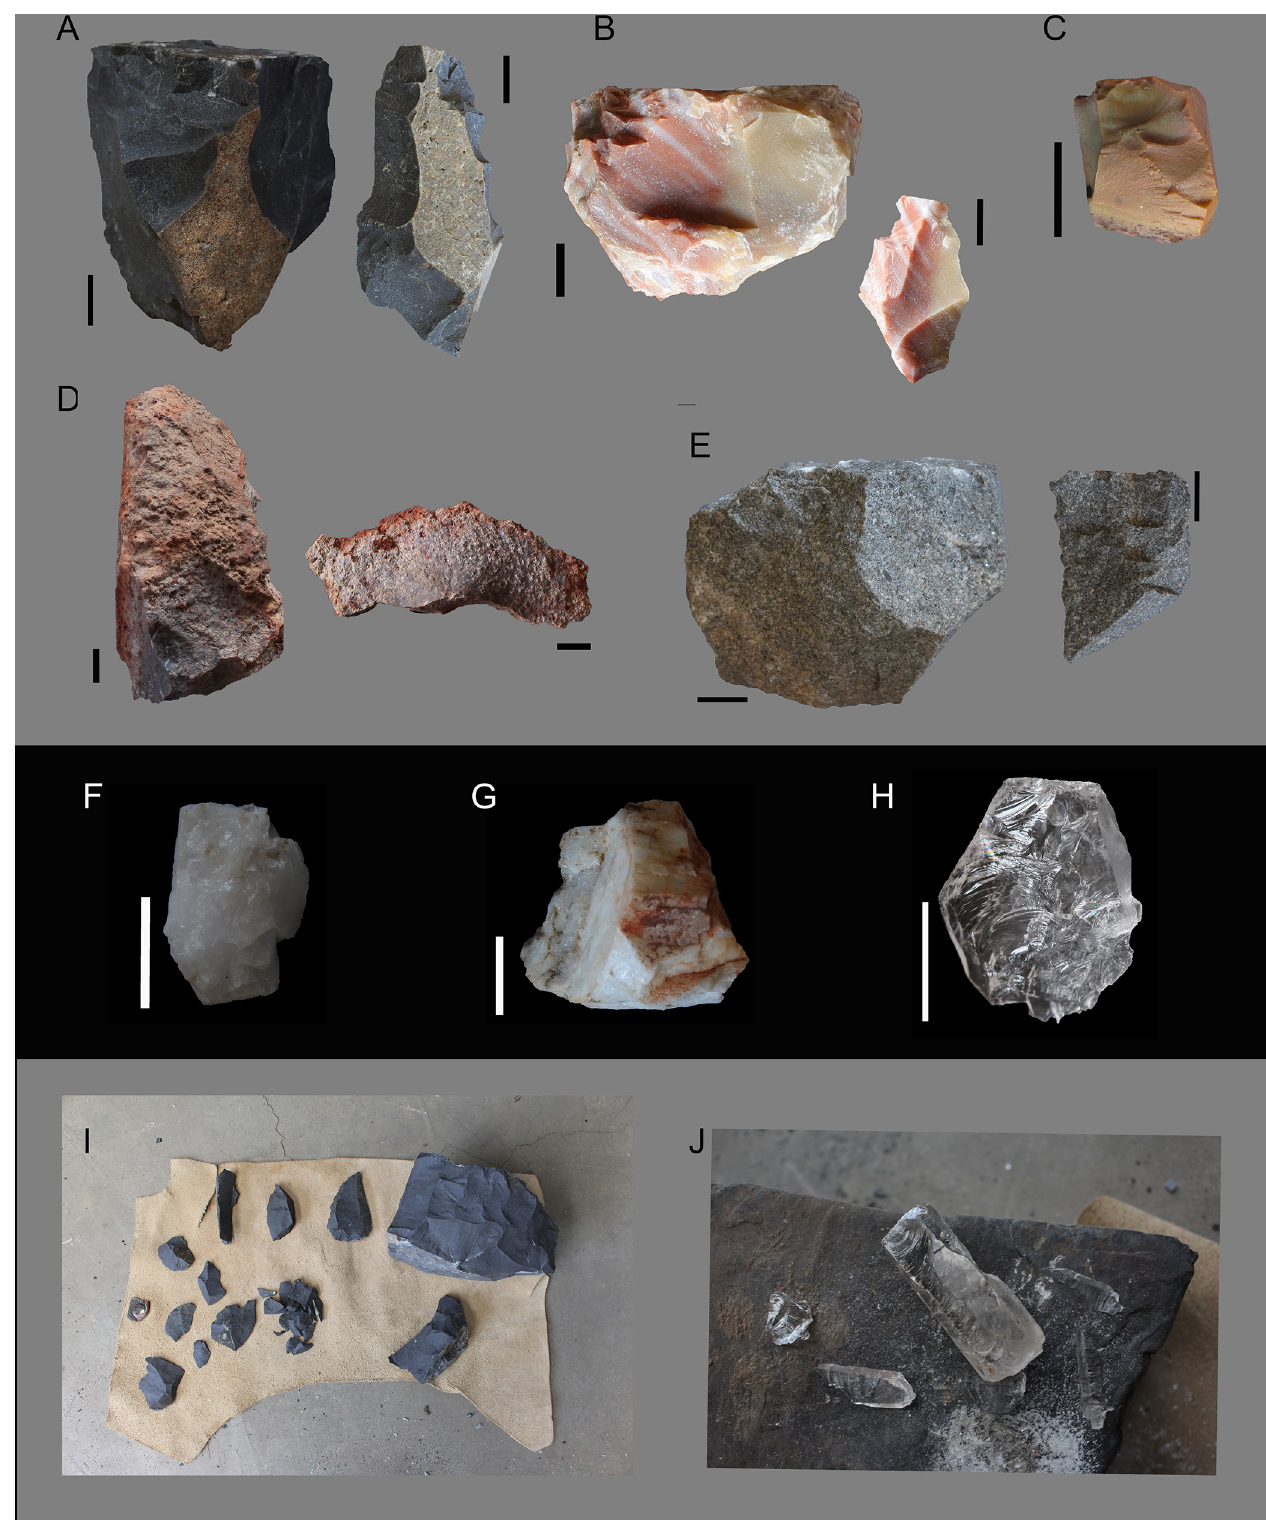
Fig 3. Raw materials used for this experiment. A. Hornfels (unidirectional core and flake). B. Jasper (unidirectional core and flake). C. Chalcedony (chunk). D. Rhyolite (core fragment) and flake (ventral view). E. Quartzite (discoidal core and flake, dorsal view). F. Xenomorphic quartz (bipolar core). G.